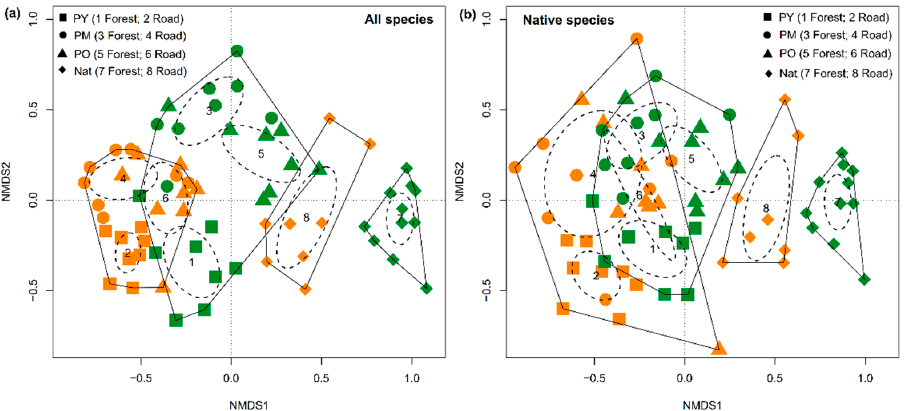
Figure 5. Two-dimensional NMDS ordination of species composition based on species cover values in forest interior (green symbols) and roadside transects (orange symbols). Ordination was conducted with all species recorded (( a ); stress value = 0.181) and with native species only (( b ); stress value = 0.201). Polygons (solid lines) frame the two forest types (plantation vs. natural forest (Nat)) separately for interiors and roadsides. The ellipses (dashed line) indicate the standard error around the centroids of the natural forest transects (Nat) and each plantation age class (PY = young plantation, PM = medium-aged plantation, PO = old to mature plantation) separately for interiors and roadsides.